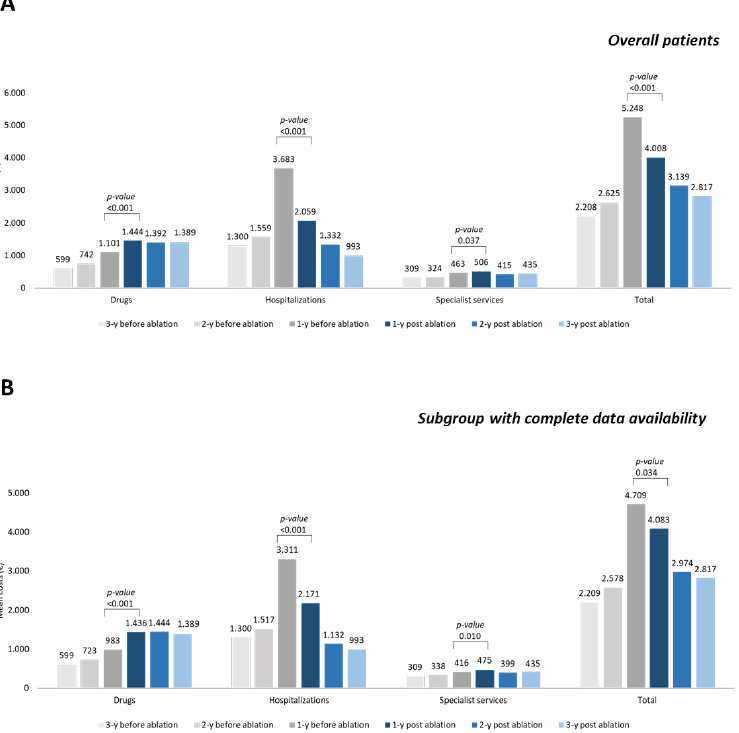
ablation procedure ( B